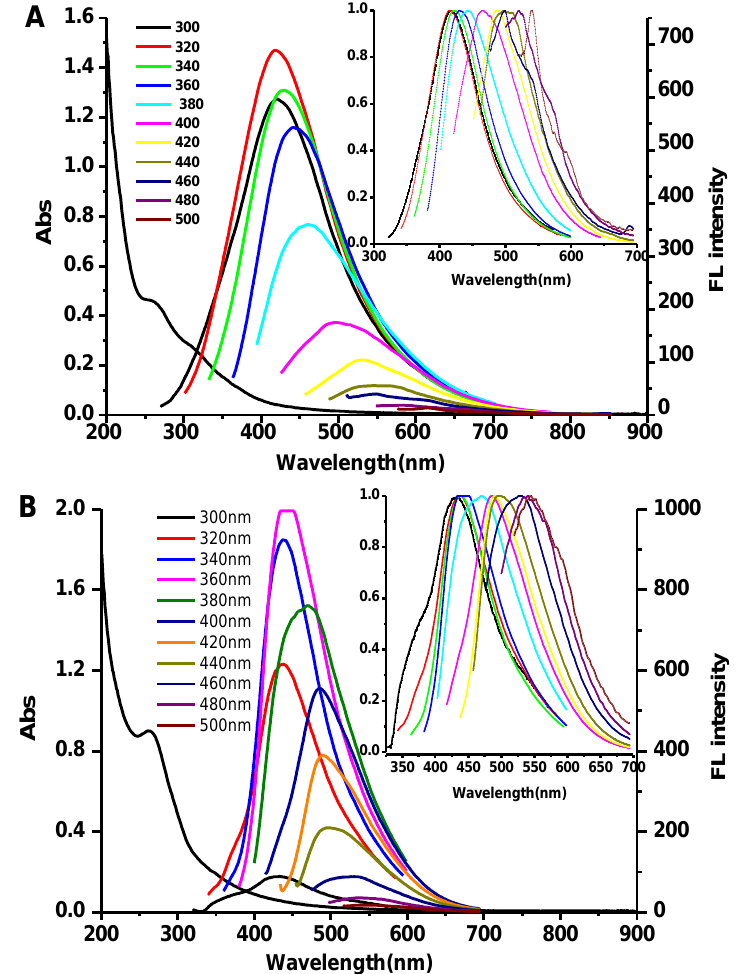
Figure 3. Ultra-violet visible absorption (Abs) and fluorescence (FL) emission spectra of polysaccharide-based NSs derived from starch ( A ) and chitosan ( B ). Excitation wavelengths were changed from 300 nm to 460 nm in 20 nm increments. Insets show the normalised emission spectra red-shifting with the excitation at longer wavelengths.